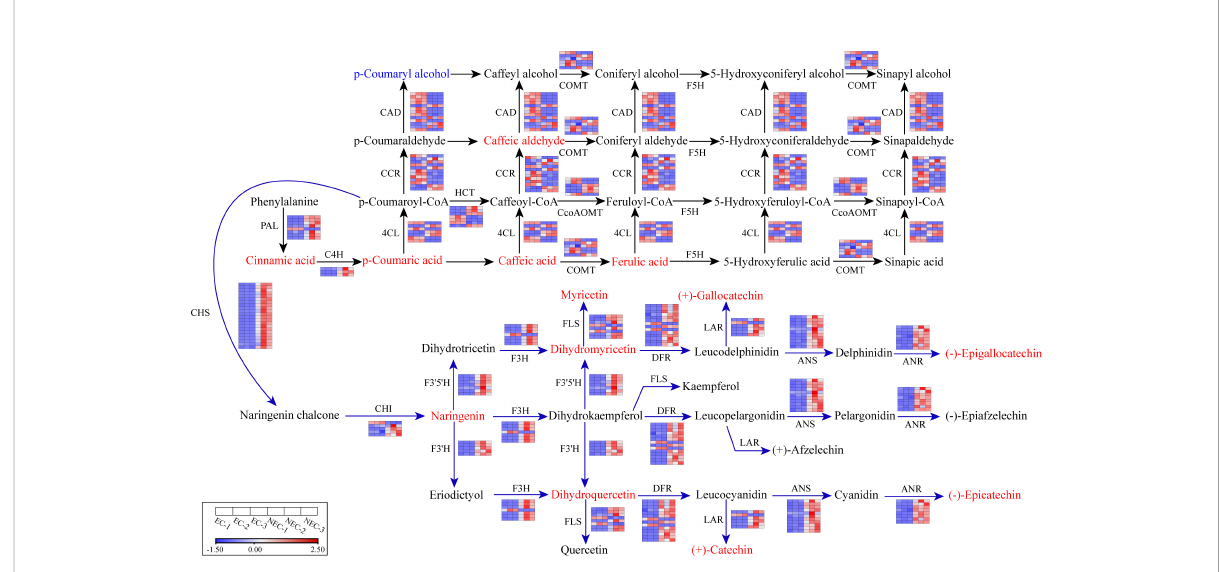
FIGURE 4 Part of phenylpropanoid and fl avonoid metabolic subnetwork with genes and metabolites that constitute the process. Enzyme names and gene expression levels based on FPKM values are indicated at the side of each step. Red and blue blocks represent upregulation and downregulation of gene expression, respectively. Upregulated and downregulated metabolites were indicated in red and blue, respectively. Enzyme abbreviations: PAL, Phenylalanine ammonia-lyase; C4H, Cinnamate 4-hydroxylase; 4CL, 4-Coumarate-CoA ligase; CCR, Cinnamoyl-CoA reductase; HCT: Shikimate O-hydroxycinnamoyltransferase; CCoAOMT: Caffeoyl-CoA O-methyltransferase; COMT: Caffeic acid 3-O- methyltransferase; CHS, Chalcone synthase; CHI, Chalcone isomerase; F3H, Flavonoid 3-hydroxylase; F3 ′ H, Flavonoid 3 ′ -hydroxylase; F3 ′ 5 ′ H, Flavonoid 3 ’ ,5 ’ -hydroxylase; FLS, Flavonol synthase; DFR, Dihydro fl avonol 4-reductase; LAR, Leucoanthocyanidin reductase; ANS, Anthocyanidin synthase; ANR, Anthocyanidin